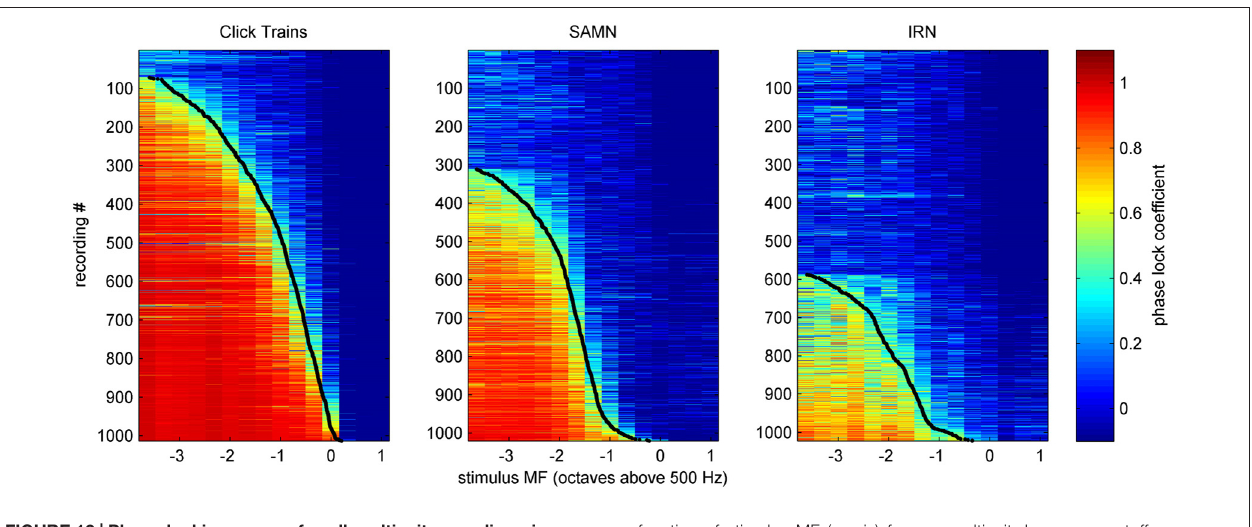
FIGURE 12 | Phase-locking curves for all multiunit recordings in our sample, in response to click-trains (left), SAMN (center) or IRN (right), sorted by low-pass cutoff frequency. Each row shows the phase-lock coefficient according to the color scale on the right as a